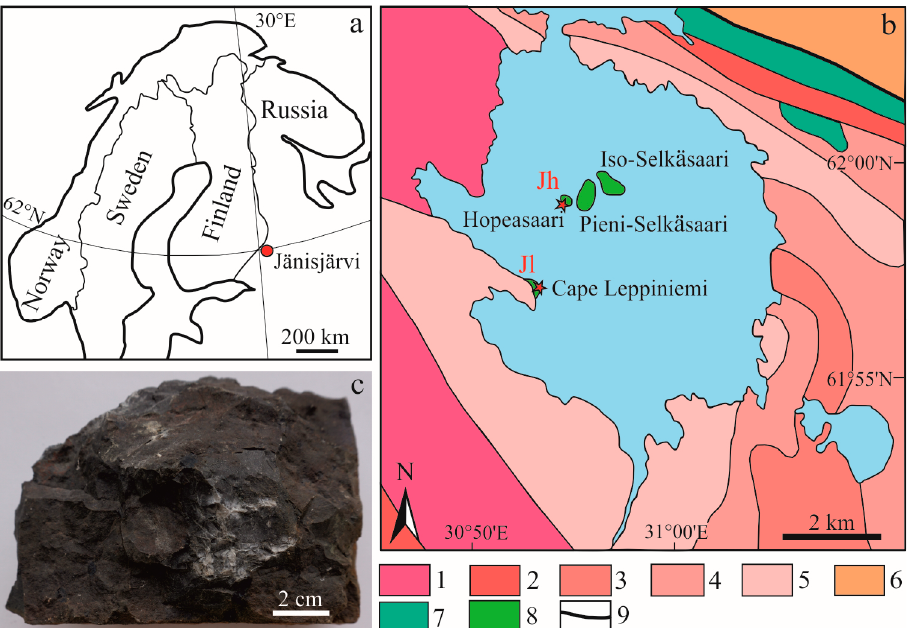
Figure 1. The geographical location ( a ). Schematic geological map ( b ) of the Jänisjärvi structure and sample Jl-01 ( c ). Crater position is marked with red cycle; sampling locations Jl and Jh are marked with red asterisks. 1—Pälkjärvi formation; 2–5—Naatselkä formation (2—undivided, 3—lower, 4—middle, and 5—upper); 6—Early/Middle Proterozoic rocks; 7—gabbrodiabase; 8—impactites; 9—faults. Modified after Reference [21].